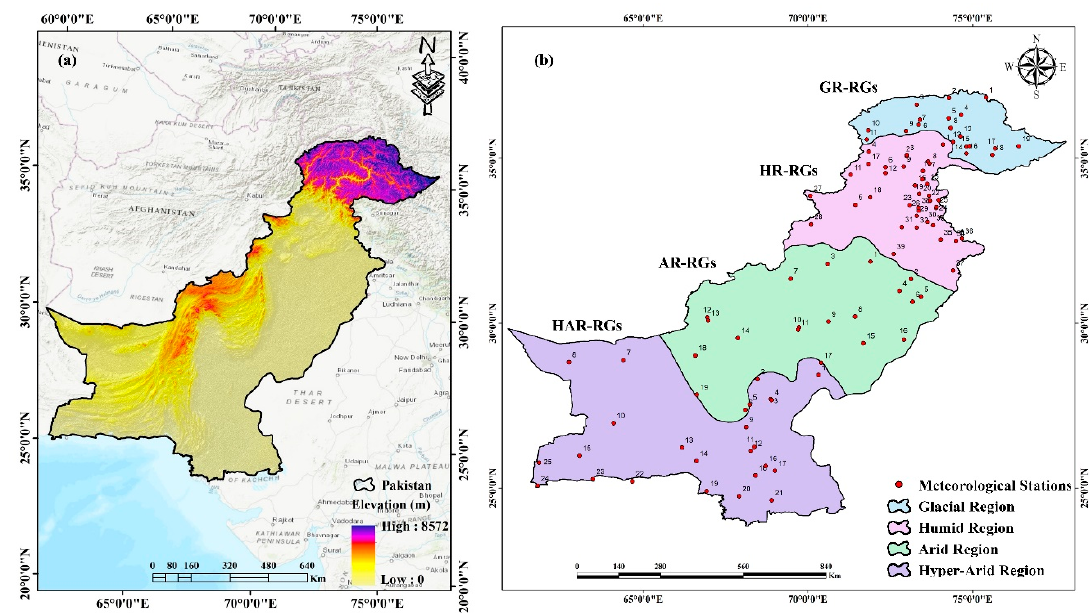
Figure 1. ( a ) Elevation map of the study area from Shuttle Radar Topography Model (SRTM); ( b ) Rain gauges denoted by GR-RGs, HR-RGs, AR-RGs, and HAR-RGs located in four climate regions, i.e., glacial, humid, arid, and hyper-arid regions, respectively.